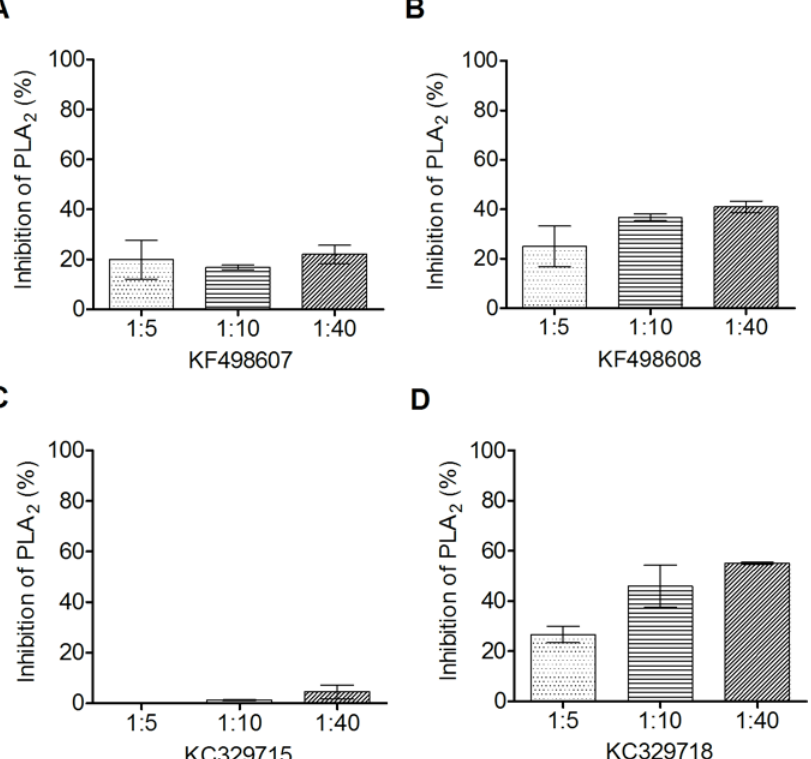
Fig 5. In vitro inhibition of phospholipase activity. The quantification of phospholipase activity inhibition by selected VHHs was assayed using synthetic fluorescent phospholipid. To verify the ability of VHHs to inhibit the phospholipase activity of BthTX-II, the toxin was pre-incubated with selected VHHs for 30 minutes at 37°C in different proportions (1:5; 1:10 and 1:40 w/w). Inhibition of phospholipase activity by (A) KF498607; (B) KF498608; (C) KF329715; (D) KC329718. BthTX-II activity on the phospholipid, in the absence of VHH, was used as a positive control, and considered as having 100% activity. The negative controls were carried out using medium reaction without BthTX-II. All measurements were performed in duplicate. Error bars represent standard